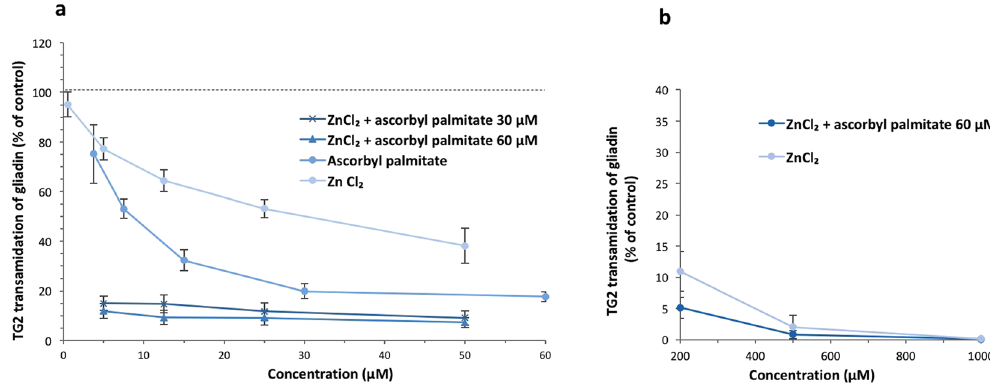
Figure 7. Dose-response experiments (5–1000 µ M) of TG2-mediated transamidation of biotin and gliadin in the presence of ZnCl 2 and fixed concentrations of ascorbyl palmitate. ( a ) The effect of ZnCl 2 (5–50 µ M) on TG2 activity in the presence of ascorbyl palmitate at 30 and 60 µ M. ( b ) 500 µ M of ZnCl 2 in combination with ascorbyl palmitate at 60 µ M was needed to completely inhibit TG2 activity. Data are presented as means ± SD (n =